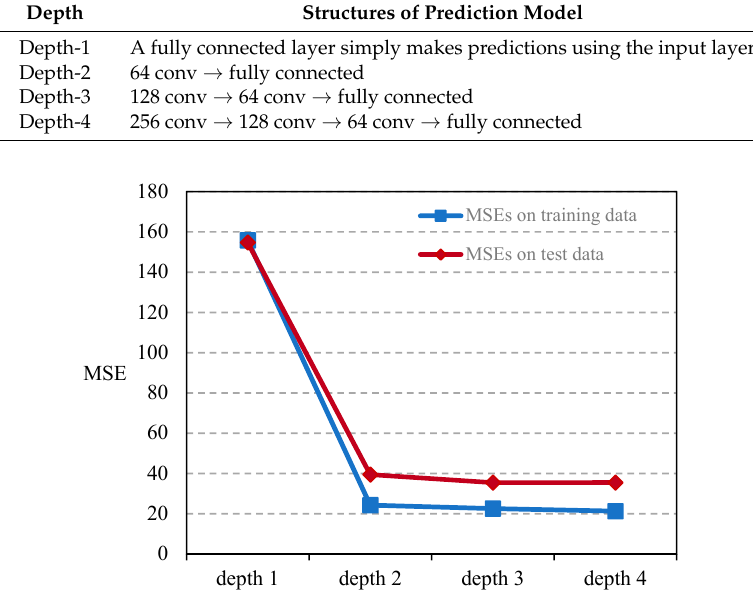
Table 2. Hyperparameters of the CNN.